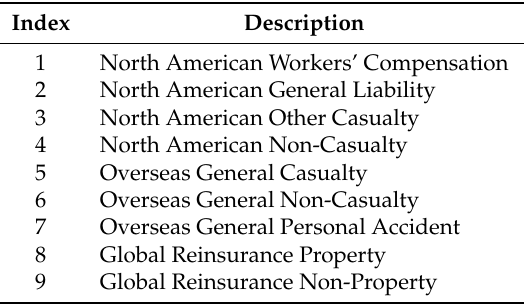
Table 1. Description of the lines of